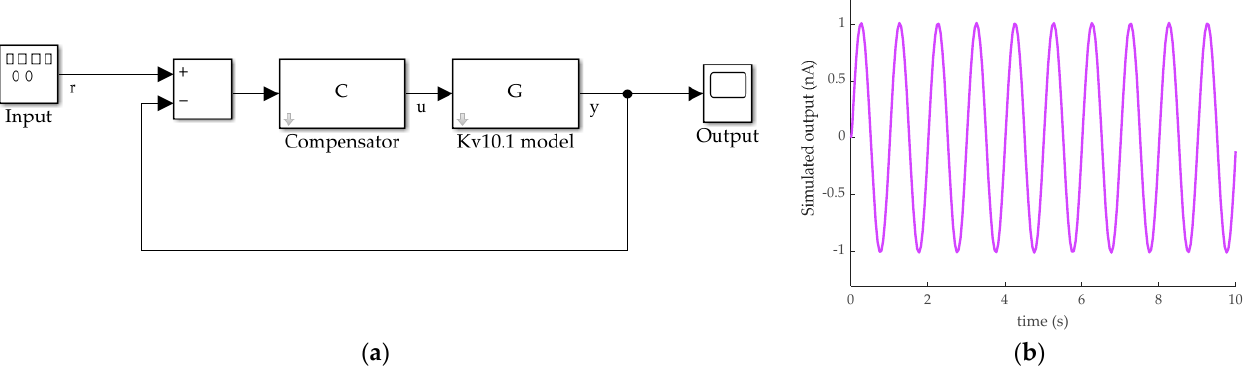
Figure 9. Simulink Kv10.1 model in a control loop ( a ); simulated output for sine input ( b ).